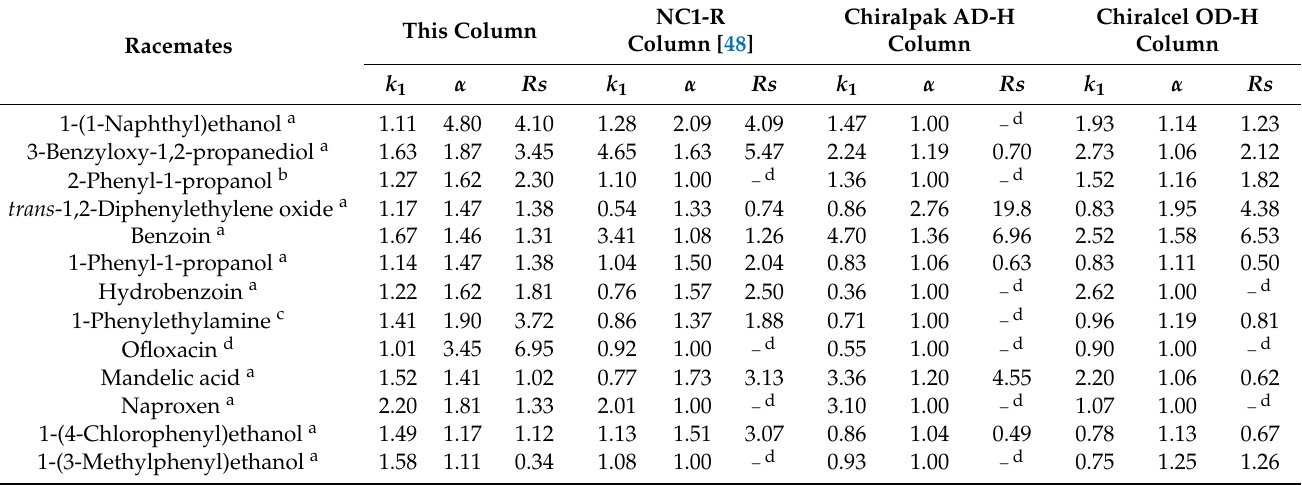
Table 1. Resolution of racemates on the chiral POC NC1-R-based column, Chiralpak AD-H, and Chiralcel OD-H